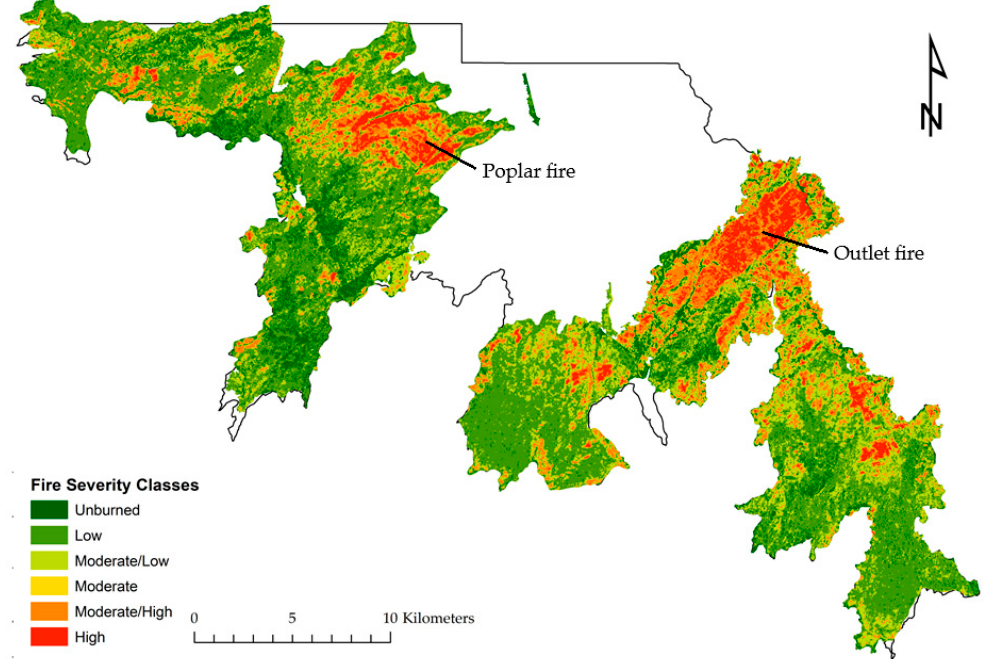
Figure 4. Map of fire severity for the North Rim of the Grand Canyon, based on MTBS data. These areas burned between 2000 and 2011. There is an increase in the amount of high-severity fire when moving north, up the elevation gradient, into the mixed-conifer and spruce-fir forests. The ponderosa pine forests on the southern peninsulas have seen less high-severity fire.